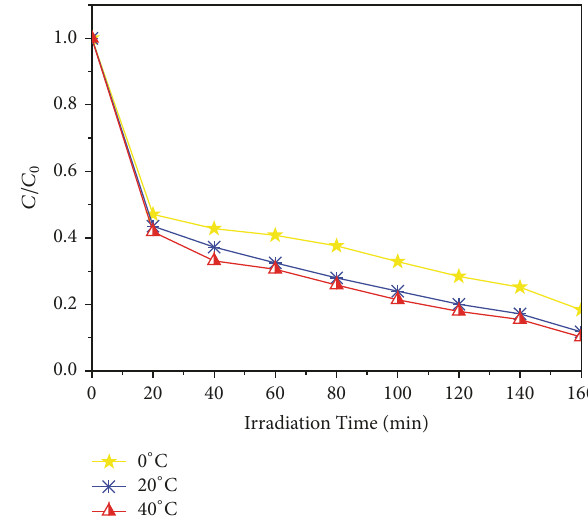
Figure 9: Influence of salinity over Sr 0.7 K 0.3 TiO 3−𝛿 @PC-polyHIPEs for photocatalytic decomposition MB under visible irradiation.